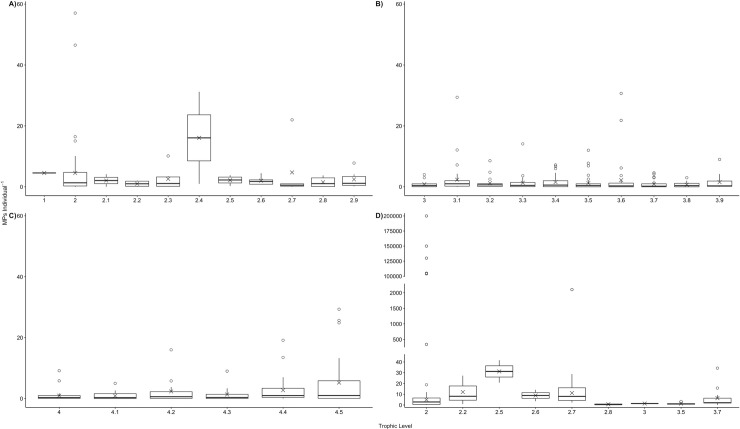
Body burden of bioaccumulated microplastics individual-1 estimated for different trophic levels, based on reports for marine species collected in situ (a) 1 to 2.9, (b) 3 to 3.9, and (c) 4 to 4.5, and exposed in laboratory experiments (d) 2 to 3.7. Data have been organised to show the minimum, first quartile, median, mean (X), third quartile, maximum and outliers (°). Trophic levels have been grouped into to a single decimal place, e.g. level 4.2 includes 4.21 to 4.29. Note different scales on y-axes in panels a-c) compared to panel d).